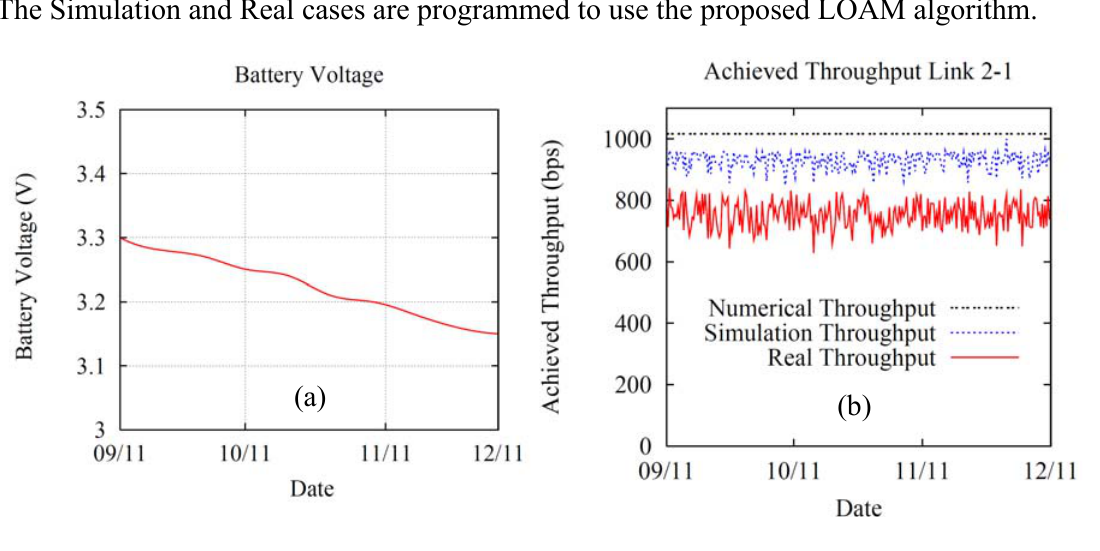
Figure 6. Metrics for the MicaZ labeled as number 2 ( a ) Battery voltage consumption during an agronomic cycle ( b ) Average throughput achieved every 8 hours for link 2-1. The Simulation and Real cases are programmed to use the proposed LOAM